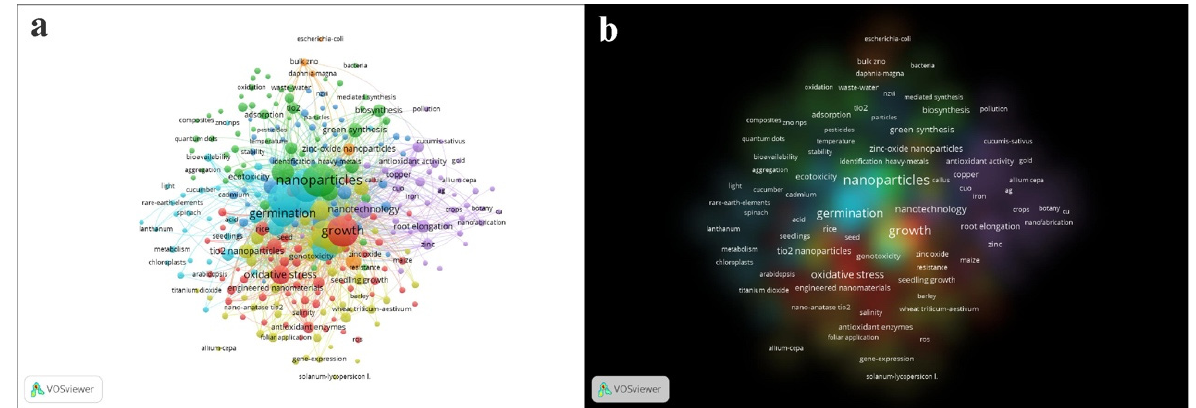
Figure 1. ( a ) Keywords of “nanoparticles/nanomaterials and seed germination” co-occurrence network visualization; ( b ) keywords of “nanoparticles/nanomaterials and seed germination” density visualization. The “curves” are the representatives of co-occurrence between the connected “nodes”, and each node denotes a “keyword”. Different keywords were segregated into different clusters, shown in different colors.